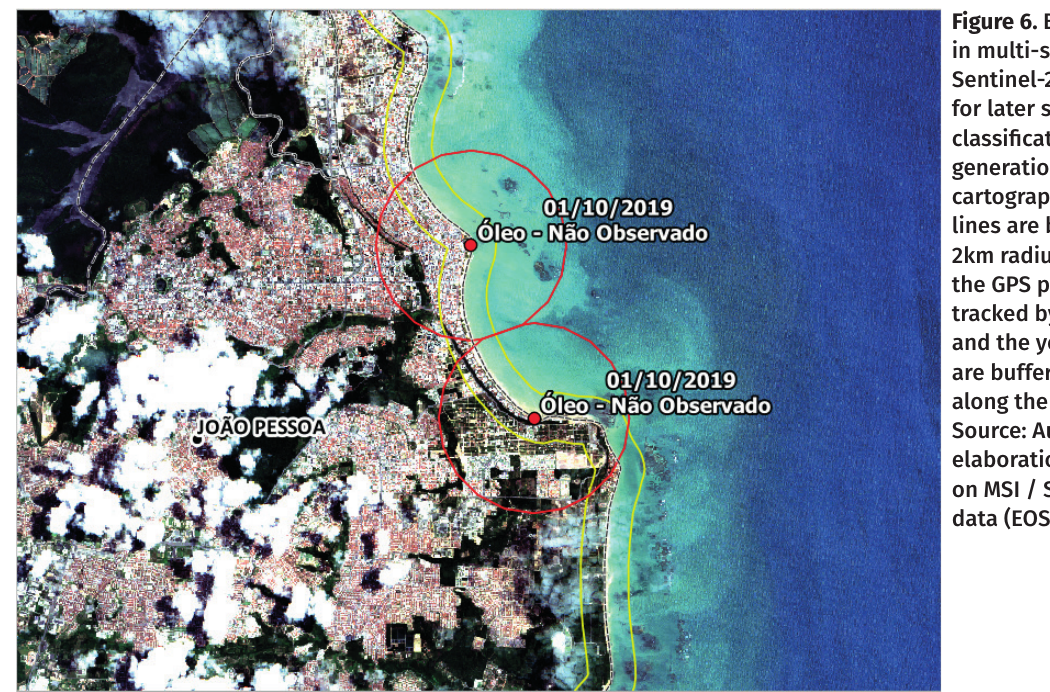
Figure 6. Buffer in multi-spectral Sentinel-2B image for later supervised classifi cation and generation of beach cartography. The red lines are buffers of 2km radius around the GPS point tracked by IBAMA, and the yellow lines are buffers of 500m along the